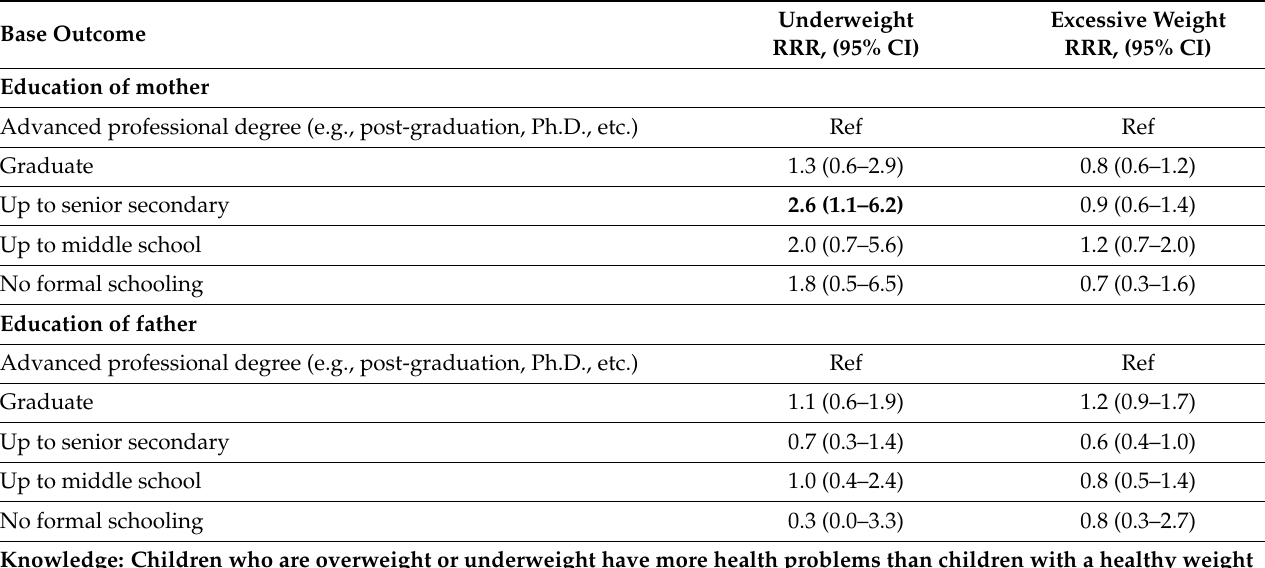
Table 3. Correlates of excessive weight and underweight (relative to normal weight) for dietary and PA knowledge and dietary